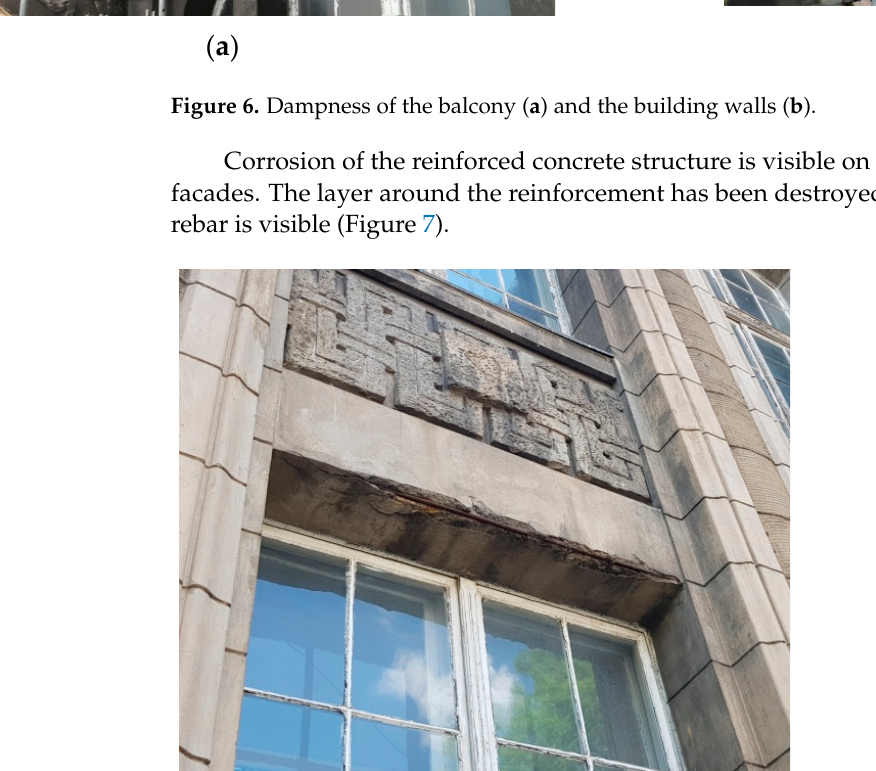
Figure 8. Cavities and areas replastered with secondary cement mortar. The windows, a large percentage of which are the original ones, present a varying degree of preservation. Due to the effects of the weather conditions, the paint coatings have become cracked and chipped, and have been subject to numerous secondary coat- ings. There is visible unsealing of the joinery joints, damage to the wood and the paint coatings, as well as numerous paint coats that are clearly detached from the wooden struc- ture of the windows. The exterior stairs, on the eastern and southern facades, were constructed of red sandstone. Their surface shows damage and cavities, and there are mosses, algae, and lichens due to the long-term presence of moisture (Figure 9).